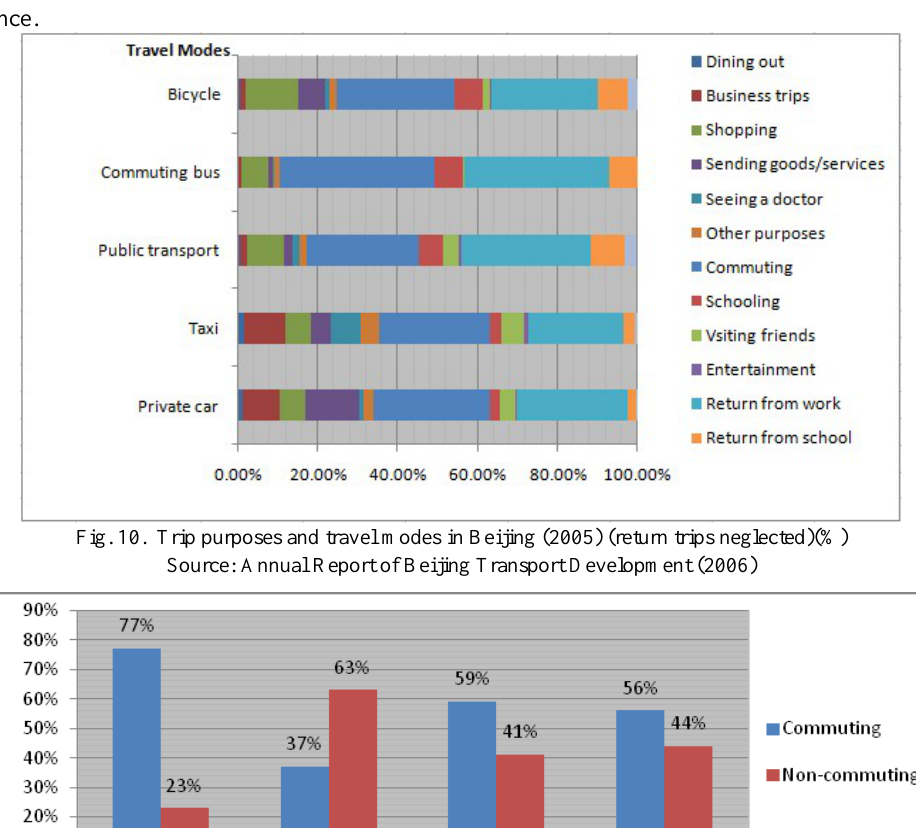
Fig. 11. Commuting and non-commuting travels in different cities London Travel Report (2007); Hong Kong Travel Characteristics Survey